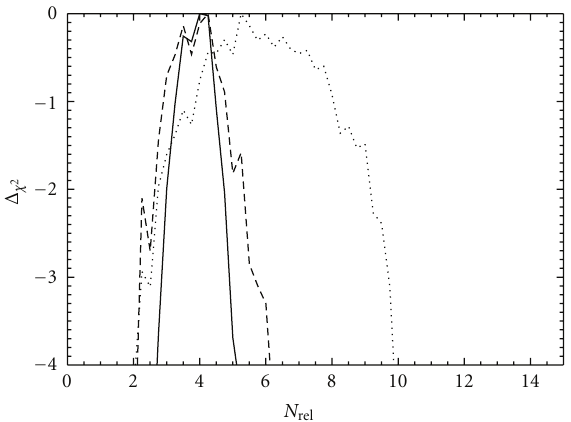
Figure 2: Constraint on the e ff ective number of relativistic neutrino species, N rel , by Stern et al. [26] using their H ( z ) measurements by the di ff erential age method. Dotted line plots the 5-year WMAP [71] likelihood, dashed line plots the likelihood with WMAP and H 0 determined by Riess et al. [72], and the solid like the likelihood with WMAP, H 0 and H ( z ) data. Adding H ( z ) data helped refining the constraint to N rel = 4 ± 0 . 5 at 1- σ level. The improvement in the constraint by adding H ( z ) data is evident. Note that this figure displays the deviation of the χ 2 statistic from its minimum − χ 2 ). The intersections of the Δ χ 2 plots with inverted ( Δ χ 2 = χ 2 min the constant Δ χ 2 = 4 line correspond to 2- σ